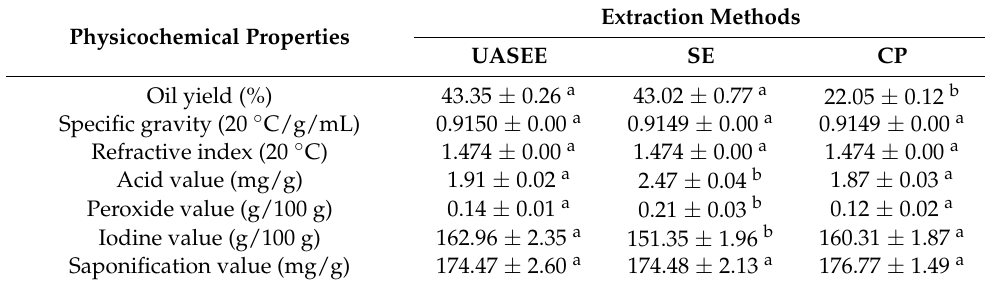
Table 3. Oil yield and physicochemical properties of E.mollis oil extracted by three methods. Physicochemical